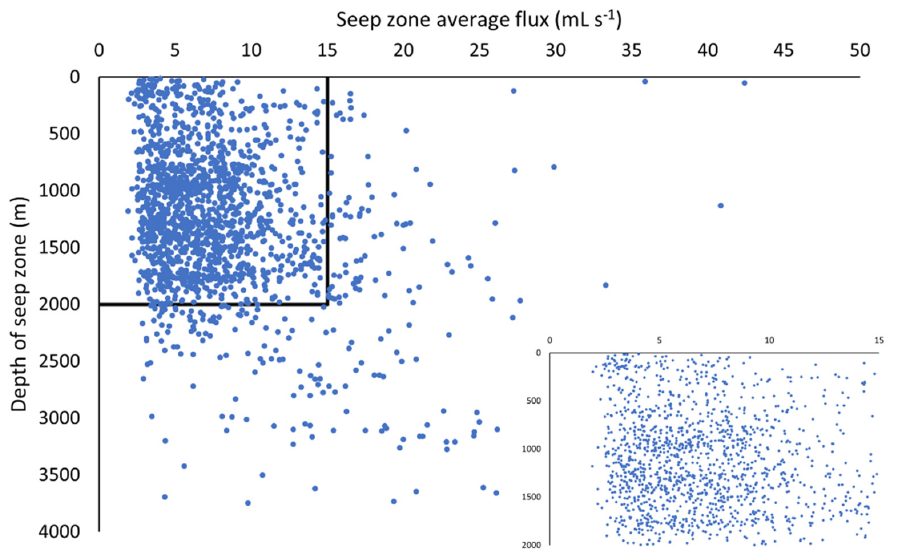
Figure 9. Frequency distribution of average flux of seep zones.